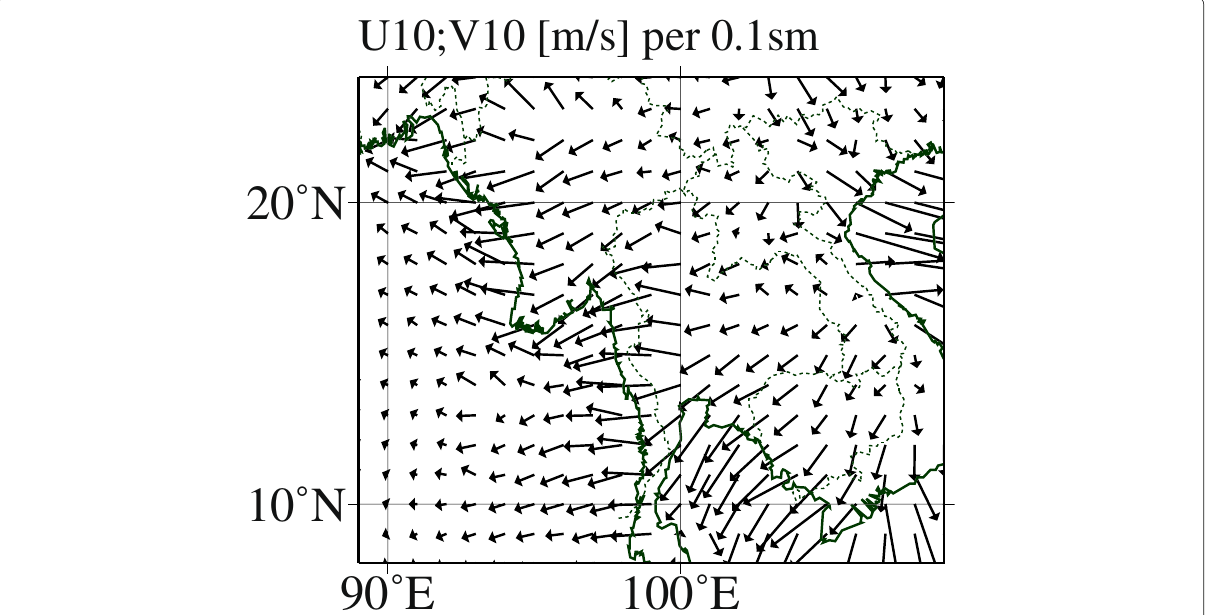
Fig. 10 Same as Fig. 3 but for winds at 10 m above the surface. The unit is m s − 1 per 0.1 increase in soil